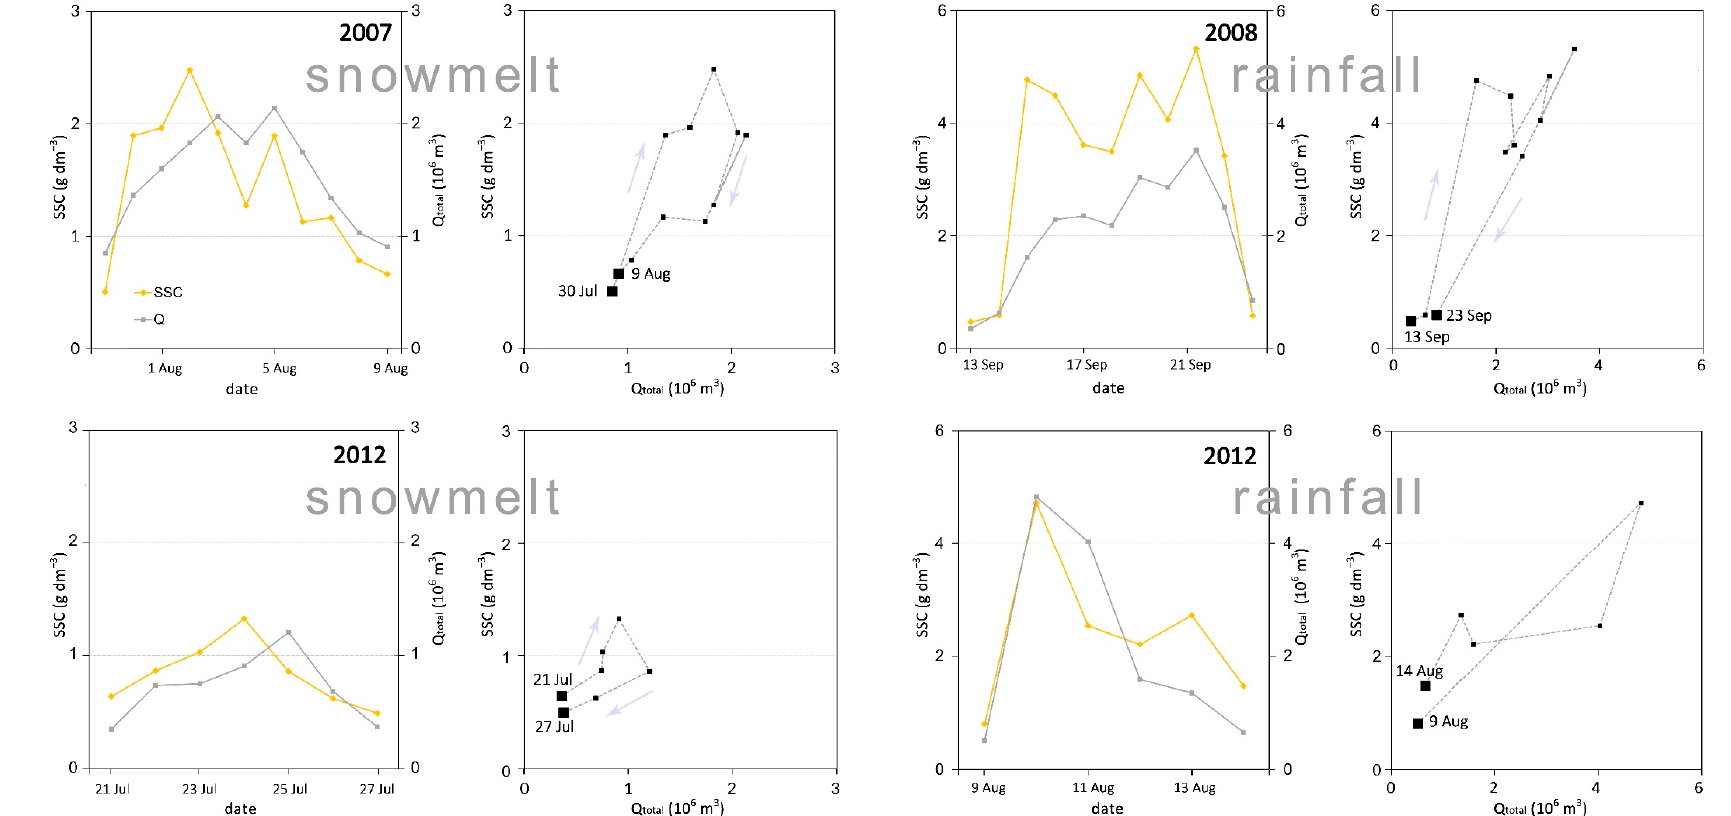
Figure 7. Hysteresis patterns between SSC and runoff in Breelva during 2007, 2008, and 2012 (examples of rain and snowmelt peak cycles).